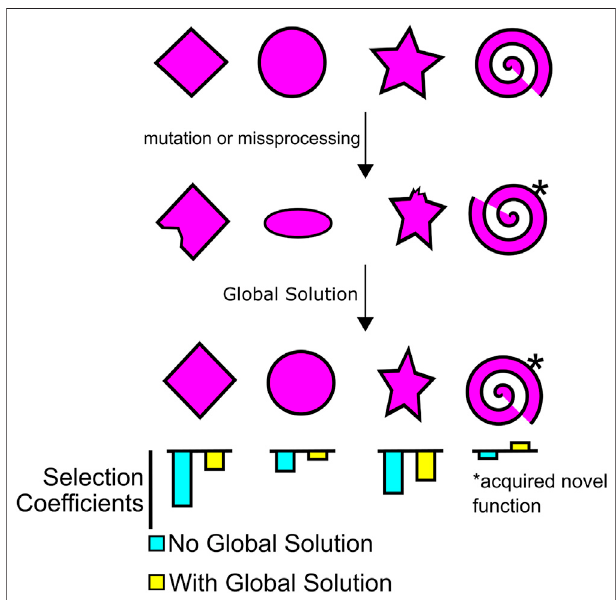
FIGURE 2 | Global solutions reduce deleteriousness and promote